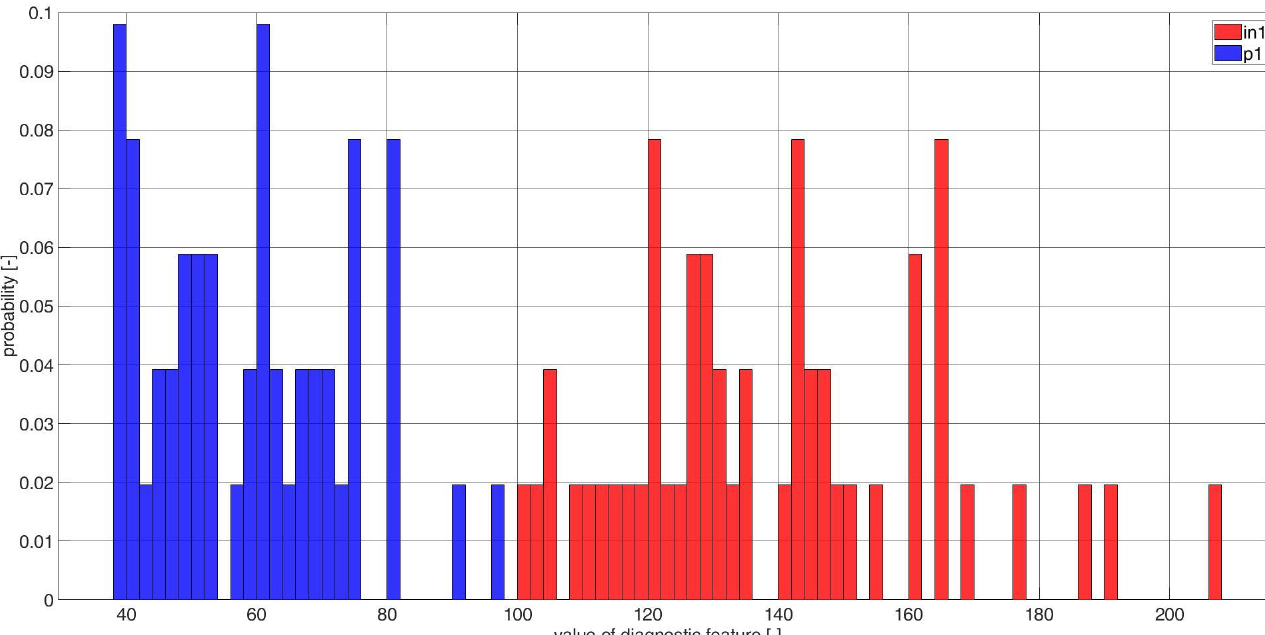
Figure A1. Histograms of diagnostic features based on the CCSM3 (correlation number is 4 — Table A1) bearings in1 and p1.